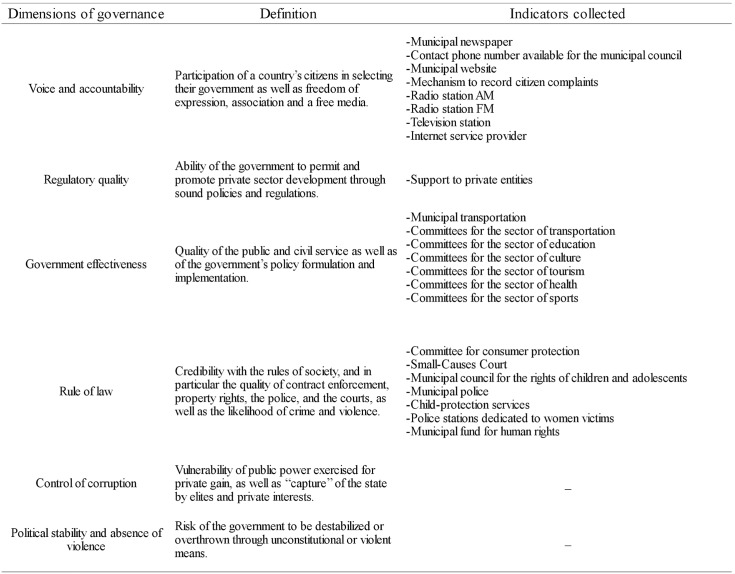
Dimensions of governance and indicators collected.Dimensions of governance established by the World Bank, their definitions and indicators collected from official statistics.